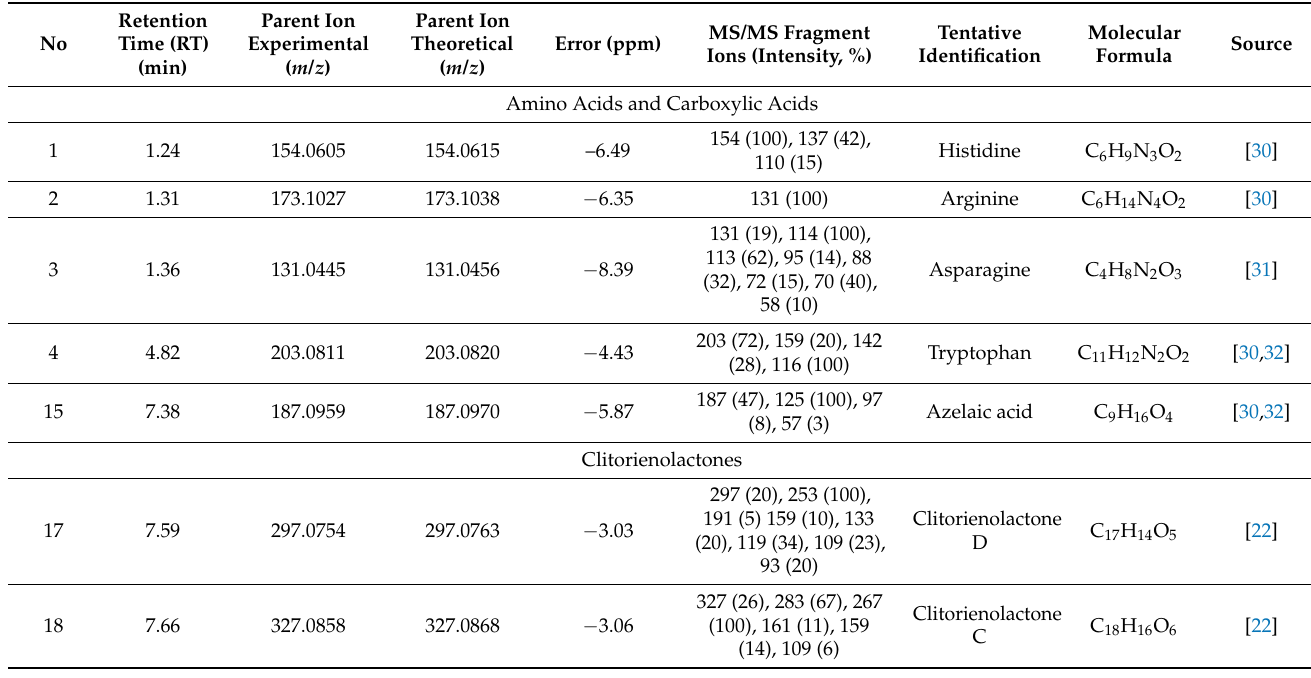
Figure 1. The LC–DAD ( A ) and LC–MS ( B ) base peak chromatogram profiles of Clitorea ternatea crude root extract in negative ion mode. Table 1. Metabolites putatively identified from the LC–MS/MS (negative ion mode) spectral data of Clitorea ternatea root